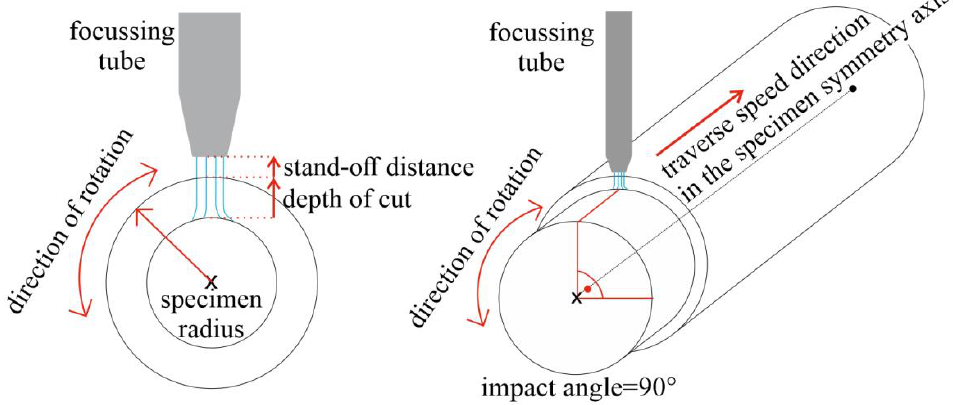
Figure 1. Scheme of the radial AWJT mode.